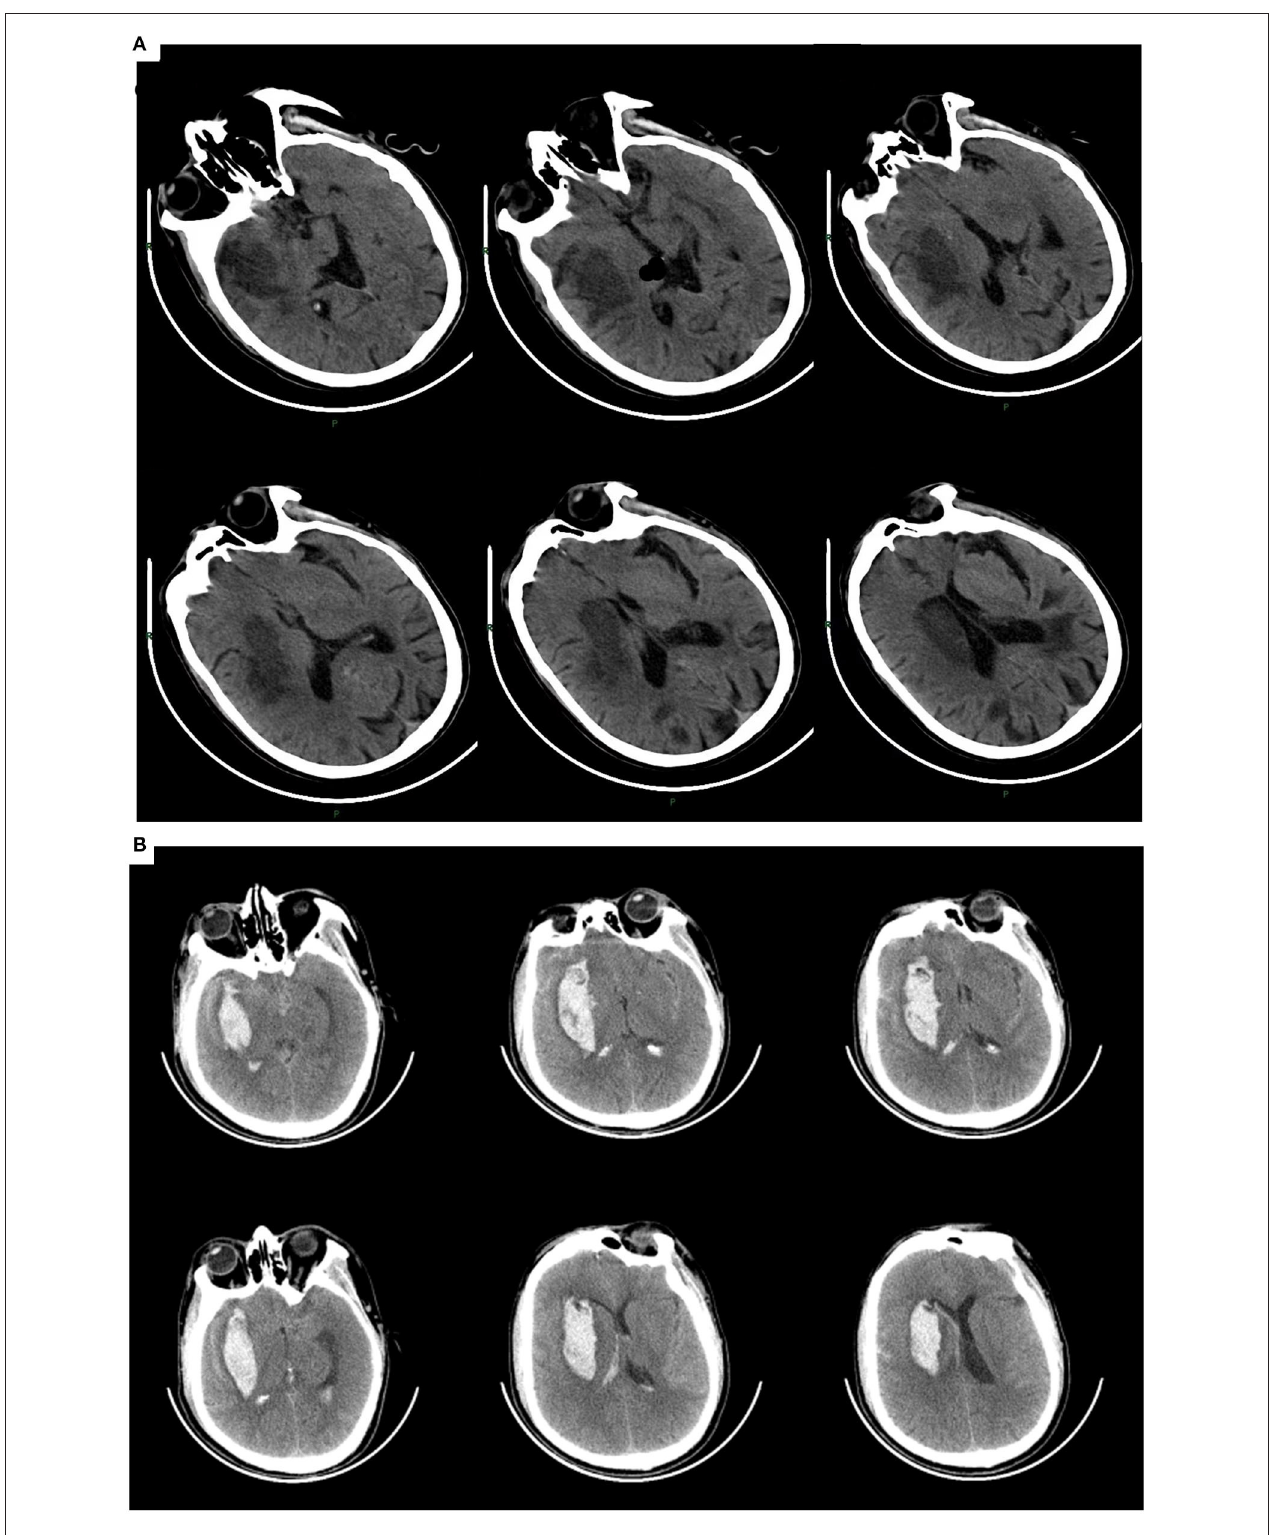
FIGURE 1 | (A) Patient 1. Cerebral infarction in the right basal ganglia involving the temporal lobe, with a previous infarction in the left occipital lobe. (B) Patient 2. Intracerebral hemorrhage in the right basal ganglia involving the temporal lobe.